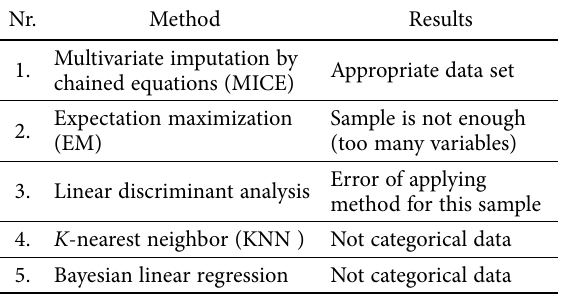
Table 1. Results of missing data